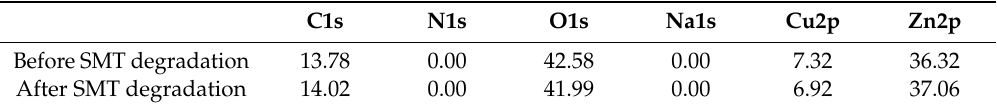
Table 1. Surface atomic percentage concentration of the elements determined by X-ray photoelectron spectroscopy (XPS) in the ZnO / Cu x = 1.25 O sample.